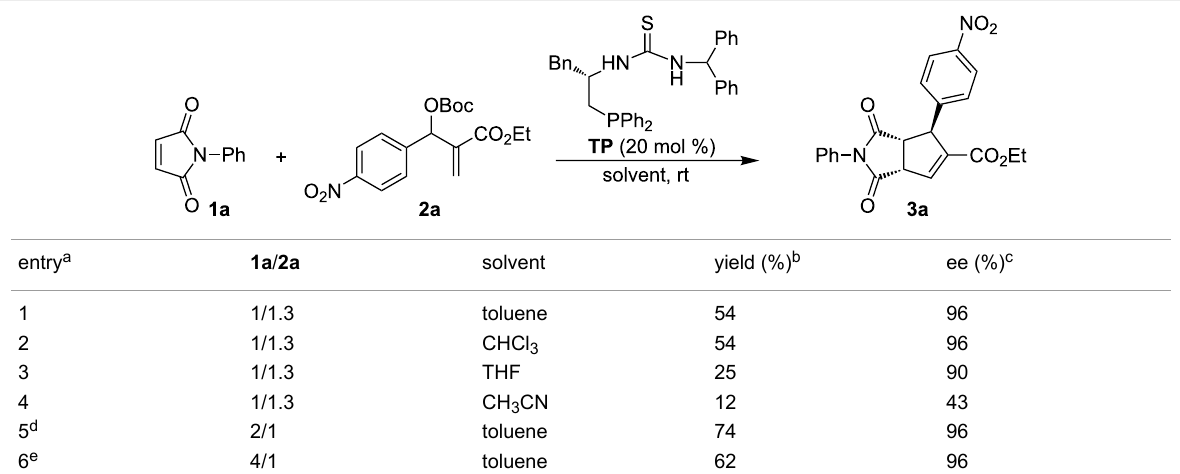
Table 1: Optimization of the reaction conditions for asymmetric [3 + 2] annulation of MBH carbonates and maleimides.